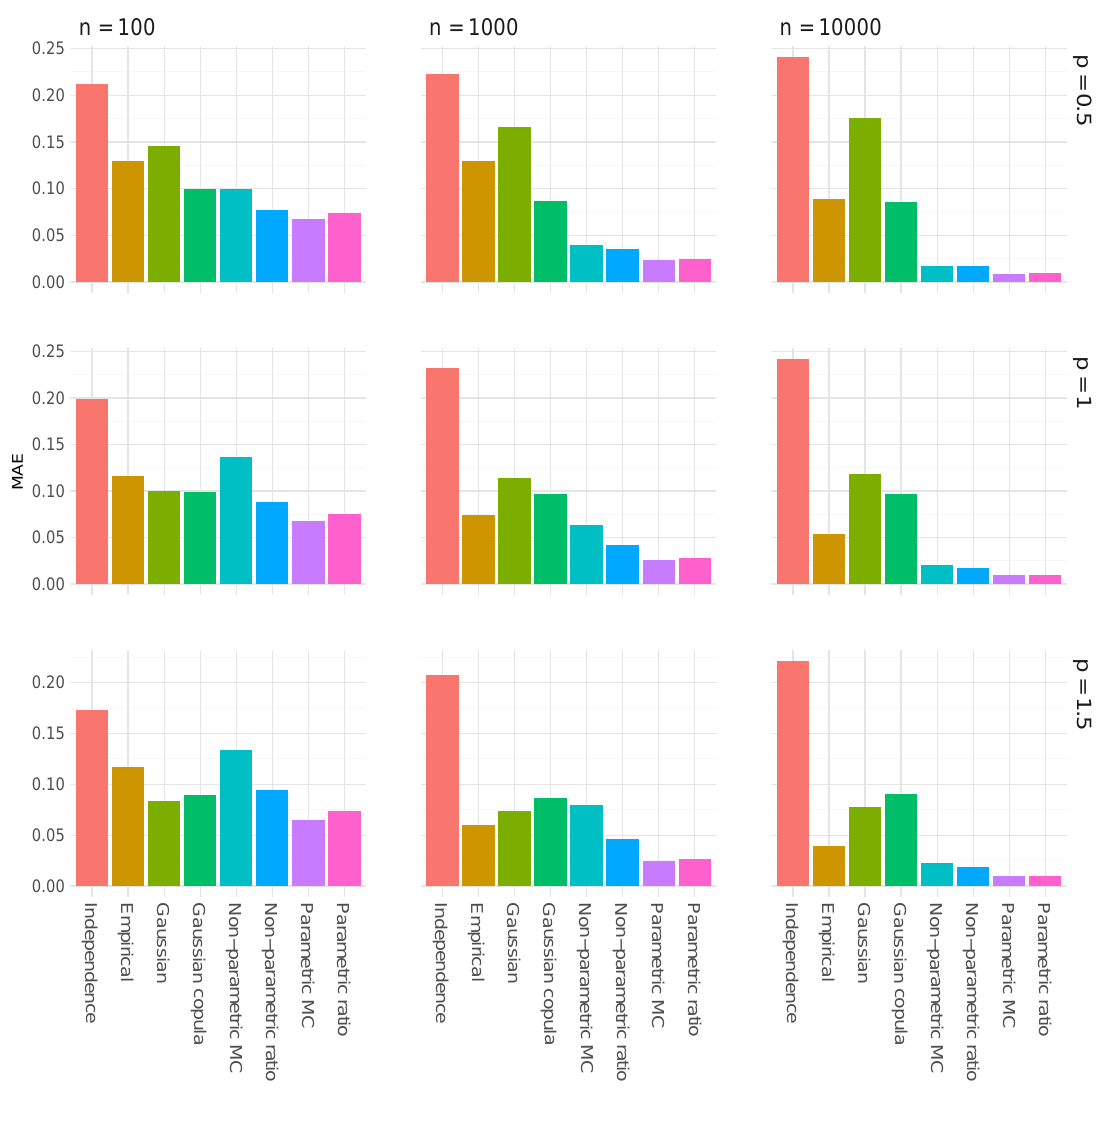
Figure 2: MAE for each combination of sample size, Burr distribution parameters and method. Each MAE-value is computed from 5000 test observations. The values 0.5, 1, and 1.5 of p correspond to pairwise Kendall’s τ s of 0.5, 0.33, and 0.25, respec-